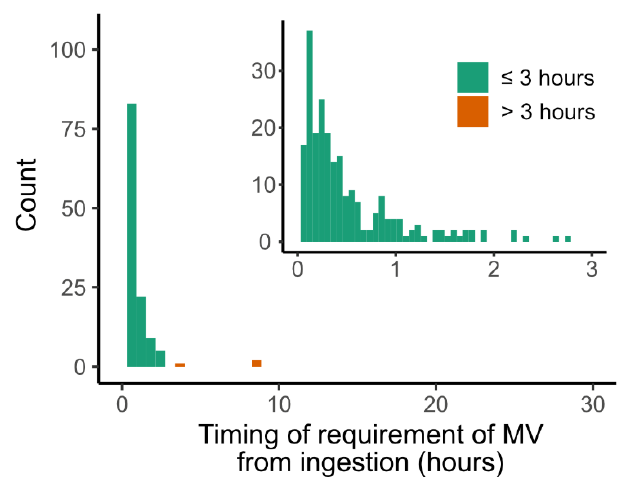
Figure 2. The timing of requirement of mechanical ventilation after pesticide ingestion. The observation period was 30 days in the larger plot and three days in the smaller plot (top-right position). MV, mechanical ventilation.